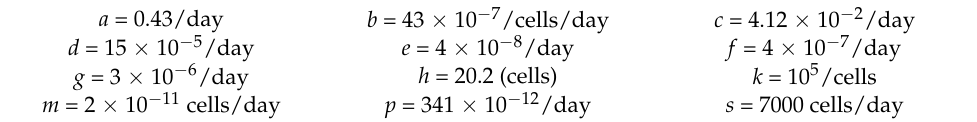
Table 1. Model parameter